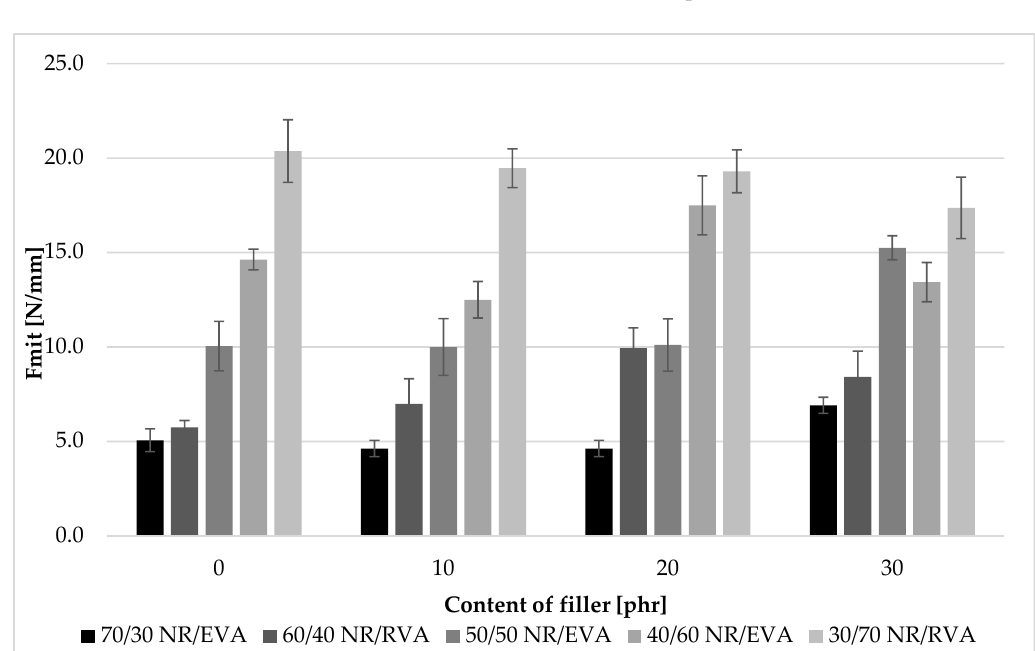
Figure 5. The average strength needed to tear the sample (Fmit) of NR/EVA or NR/EVA/straw Figure composites.